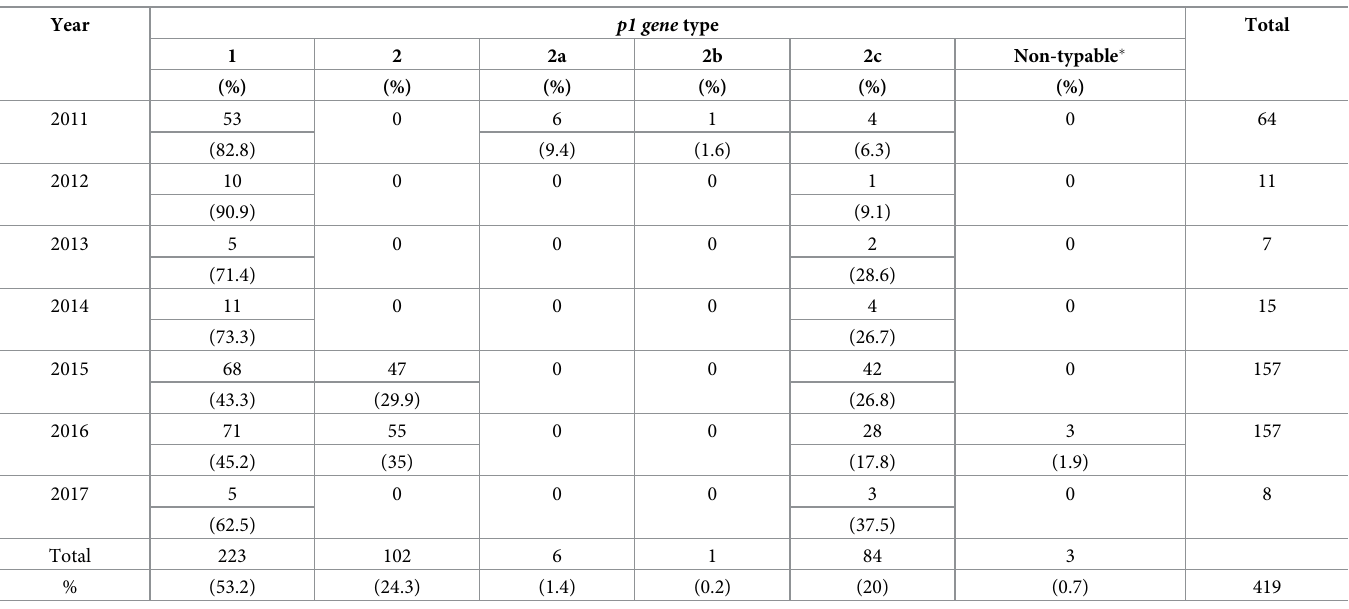
Table 3. Annual distribution of p1 gene typing results in M . pneumoniae . Year